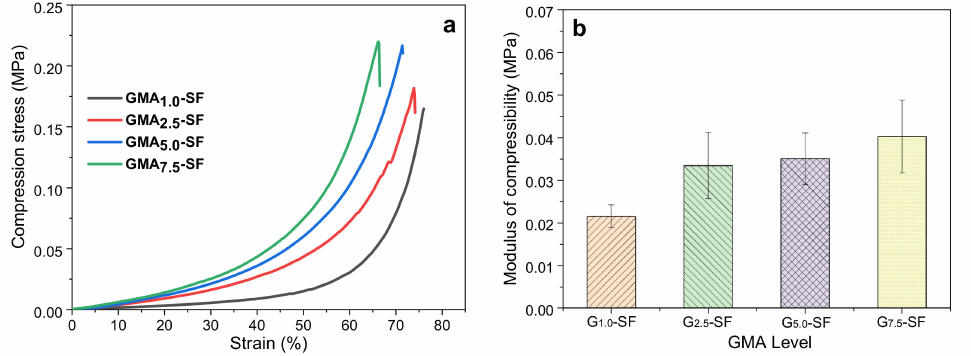
Figure 3. Effect of GMA content on mechanical properties of alone SF scaffolds: ( a ) stress–strain curve; ( b ) compressive